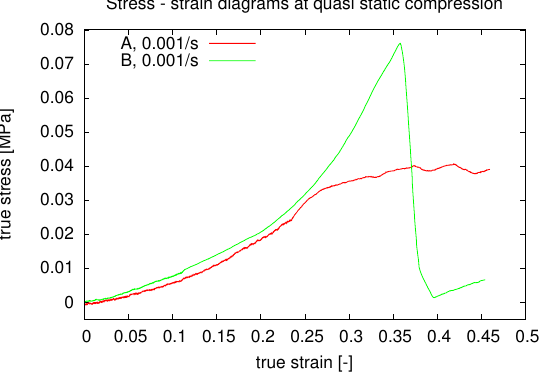
Figure 3. Stress-strain curves of quasi-static